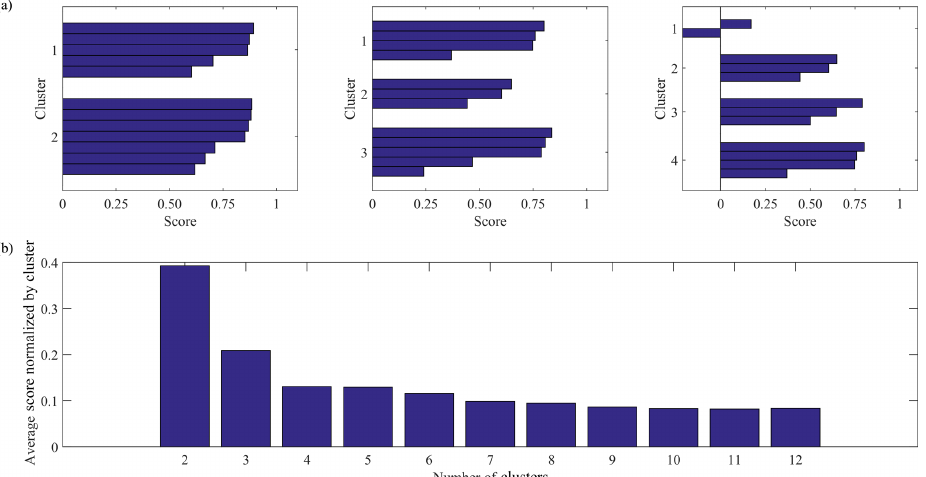
Figure 3. (a) Scores for each cluster analysis of observational data in the North Atlantic for k = 2, k = 3, k = 4, where cluster k is the predetermined number of clusters and each bar represents the score per 2-D histogram. (b) Average scores for each cluster analysis with increasing k , from k = 2 ,..., 12, normalized by the number of clusters k